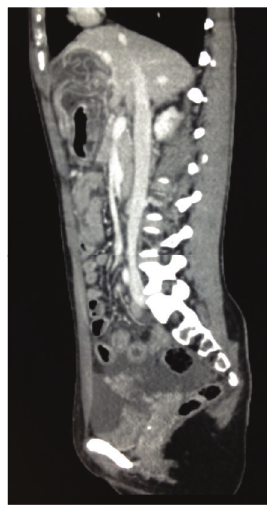
Figure1:ContrastCT(Sagittalsection)demonstratingtheruptured hydatid cyst within the anterior portion of the left lobe of the liver, with serpiginous strands representing the collapsed membrane. Significant free fluid is noted within the pelvis.